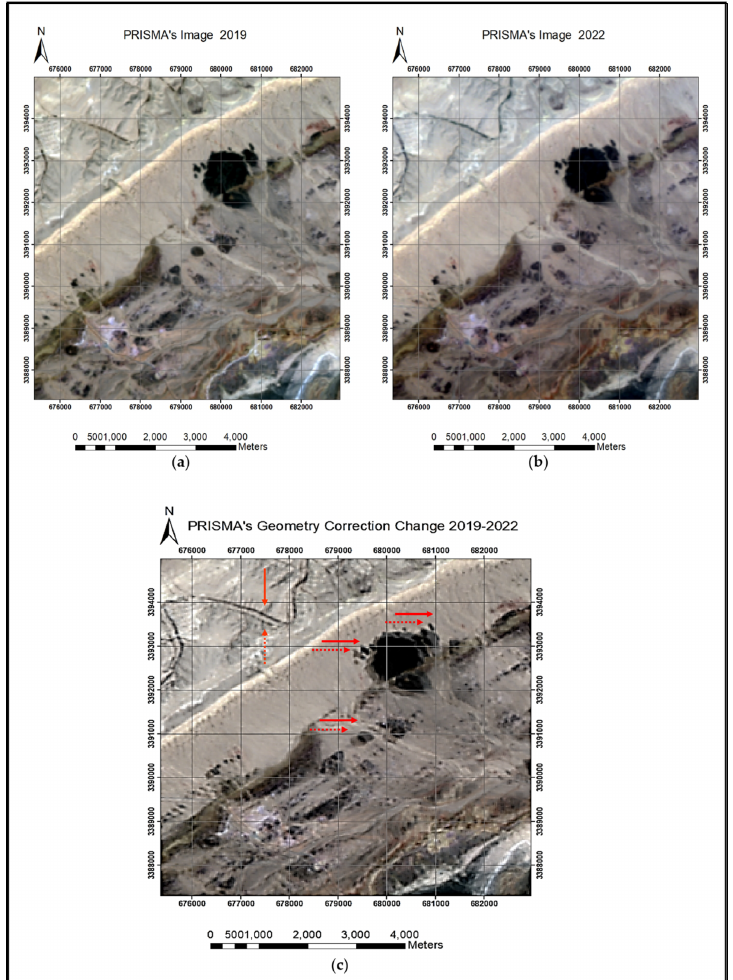
Figure 15. Comparison of PRISMA’s 2019 and 2022 geometric corrections: ( a ) 2019 MR image; ( b ) 2022 MR image; ( c ) 2022 image overlaid on 2019 image. Several drifts in the geolocation are marked with red arrows (2019—solid; 2022—dashed).